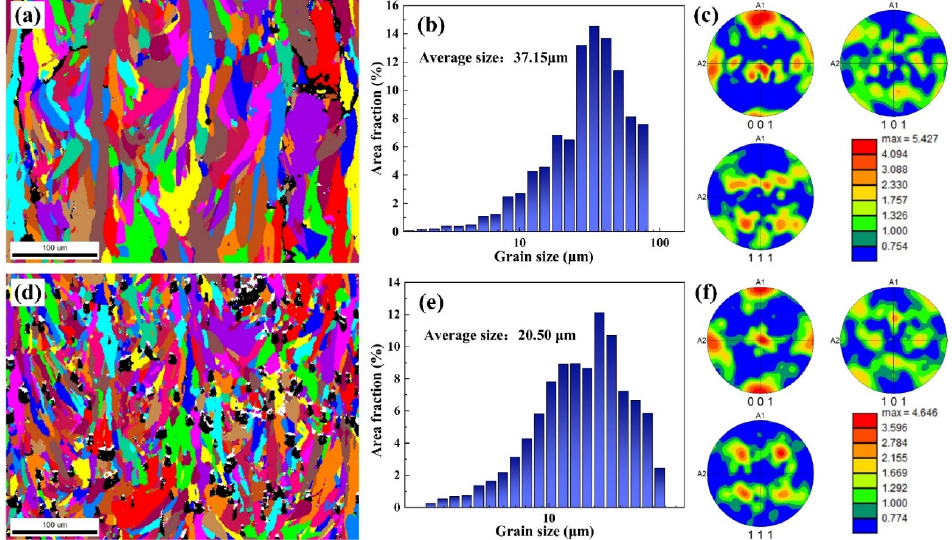
Figure 3. Grain maps, grain size distribution histograms, and PFs along the lateral section of the as-printed ( a – c ) S0 and ( d – f ) S4 samples.